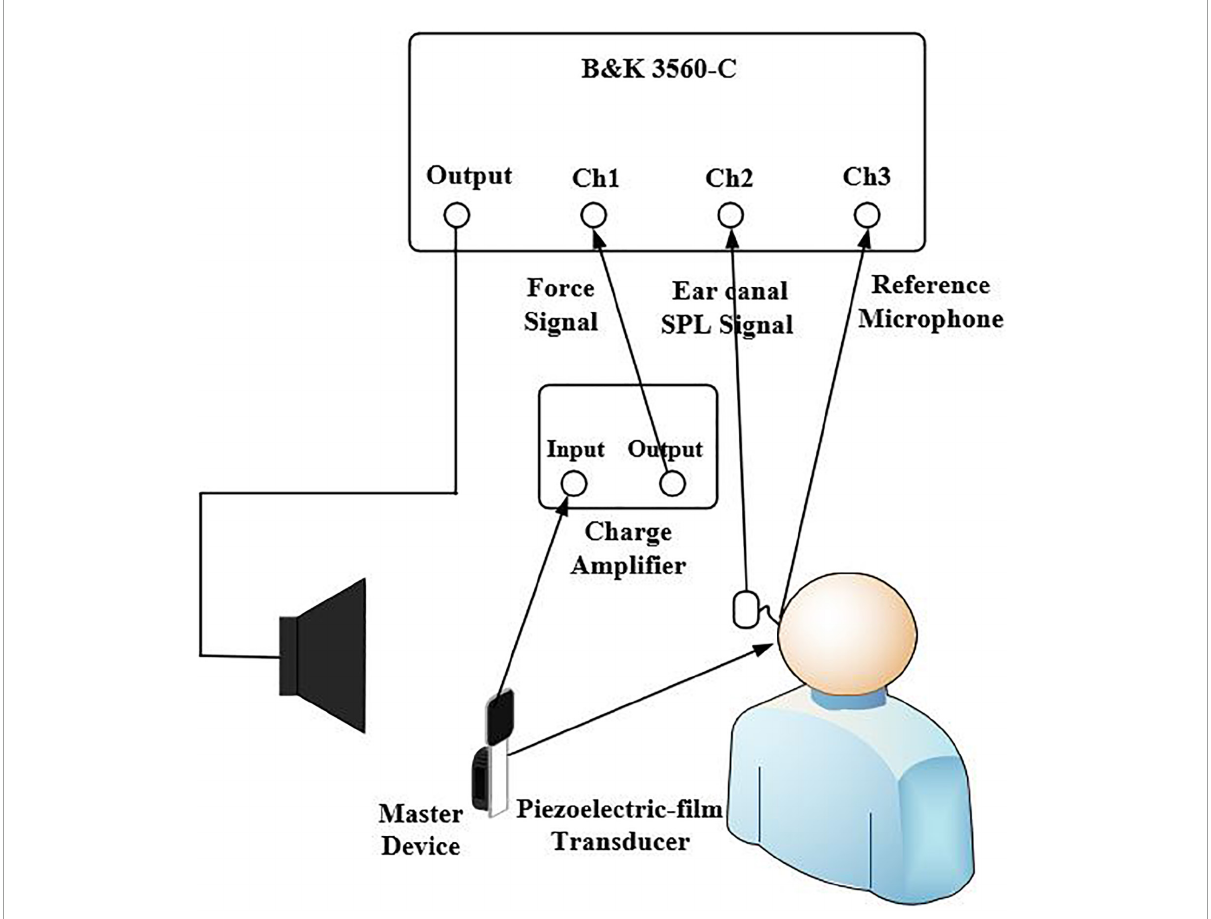
FIGURE2 Experimental setup for the force transducer and the probe microphone aided response measurements. The loudspeaker was used to present the pink noise and the reference microphone was placed at the entrance to the master BC hearing aids microphone to monitor the overall SPL of the signal. The probe microphone was placed in the ear canal for the SPL measurements and the force transducer was placed tightly between the B81 transducer and the stimulation position for the FL_FT